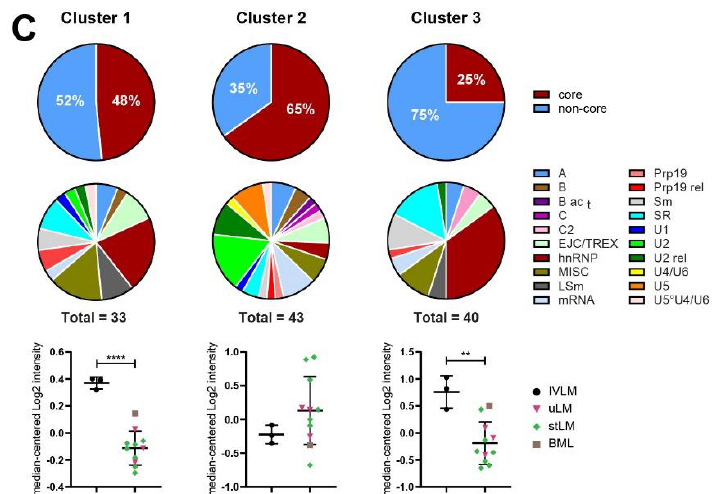
Figure 4. ( A ) Heatmap depicting unsupervised hierarchical clustering of 116 proteins of the spliceosome complex as defined by Hegele et al . [30] . The distance measure used for clustering is Pearson’s correlation. ( B ) Heatmap depicting similarity matrix of Pearson’s correlation coefficients of all possible pairwise combinations of the 116 splicing factors. Three clusters were identified by consensus clustering analysis. ( C ) Annotation and expression profile of the spliceosomal proteins belonging to clusters shown in Figure 4B. Venn diagrams depict spliceosome composition (core versus non-core, and distinct splicing factor classes) in each cluster while plots below show average expression levels of spliceosome components in each sample for a given cluster. The detailed composition of clusters and the identity of individual proteins are listed in Table S2. The line and whiskers in plots represent mean and standard deviation. Statistical significance was calculated by two-sample t -test. ** p < 0.01, **** p < 0.0001.